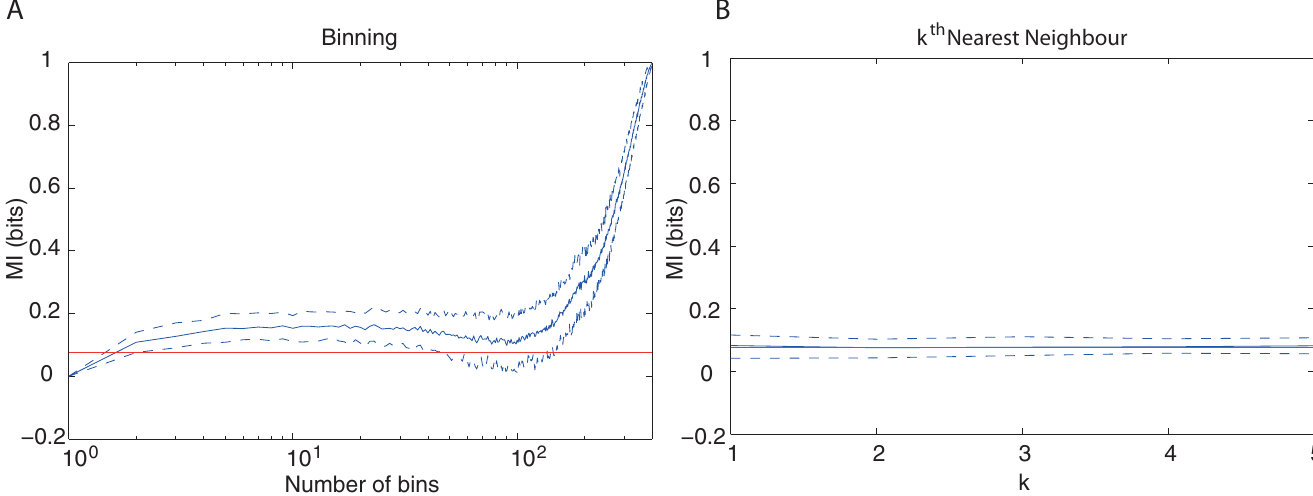
Fig 2. Simulation for Gaussian conditioned probability. (A) MI estimation using the binning method with QE correction, as a function of the number of bins used. (B) MI estimation using the method of the k th nearest neighbours, as a function of the chosen k value. Sample size was N = 400, red line indicates the true value of MI, blue line indicates mean MI value for 100 data sets of size 400 each. The interval between dashed blue lines indicates 10% lowest to 10% highest